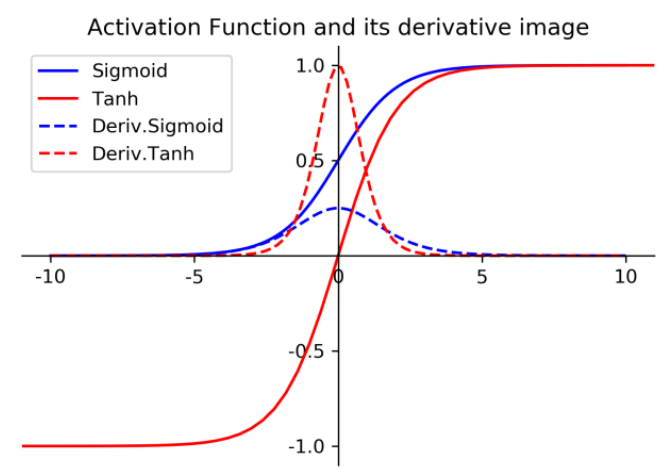
Figure 8. Curve of the Sigmoid and Tanh functions.